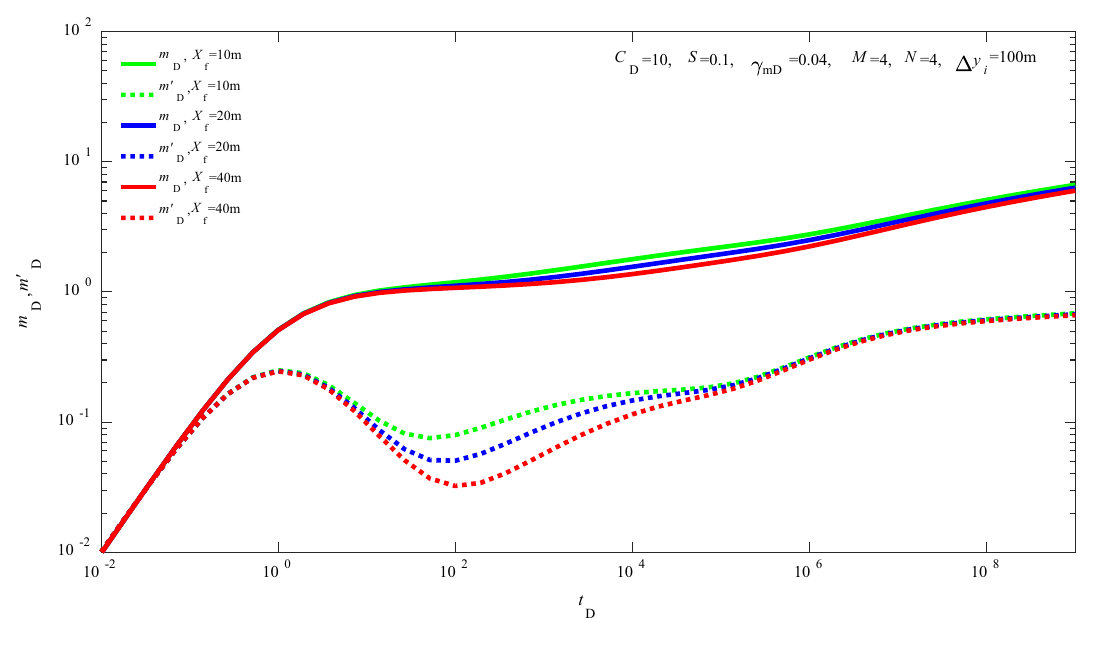
Fig. 7 Effect of fracture half-length on transient pressure curves Rate transient analysis of producing at a constant damage, so the worse the reservoir property is, and the lower bottom‑hole pressure the production rate under constant pressure will be, resulting in a steeper downwarping of the production decline curve and a more obvious upwarping of the derivative curve. Figure 8 reflects the effect of permeability modulus γ mD Figures 9, 10 and 11 successively reveal the rate decline on rate decline curves. The greater of γ , the stronger of mD curves affected by fracture number ( M ), fracture spacing the stress sensitivity, i.e. the more serious of permeability